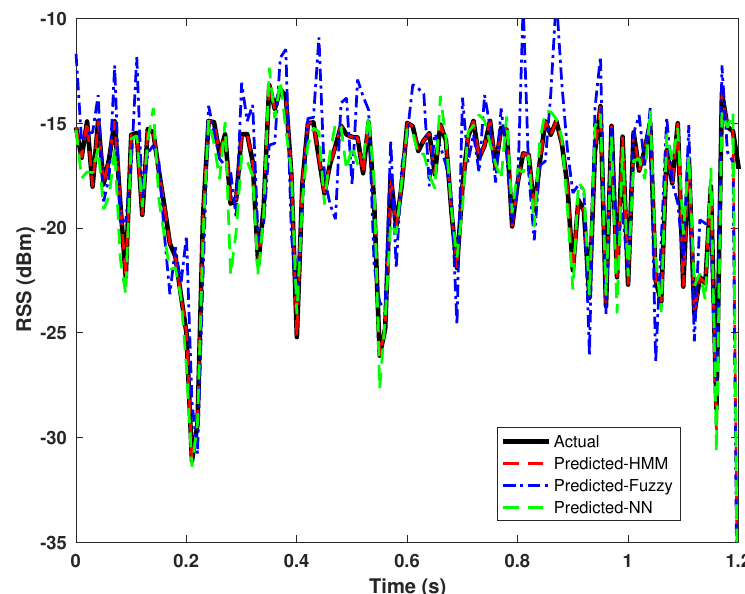
Figure 4. Actual versus Predicted RSS Values of the VLC–WiFi APs; HMM, Fuzzy, NN.